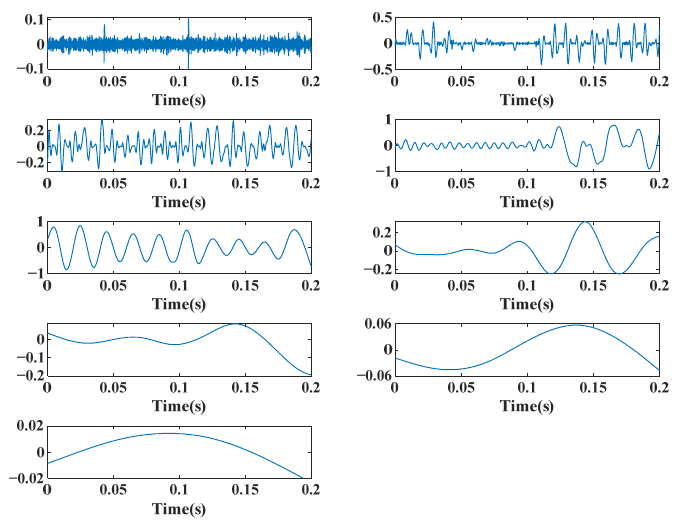
Figure 10. Decomposition results in time domain by EMD.